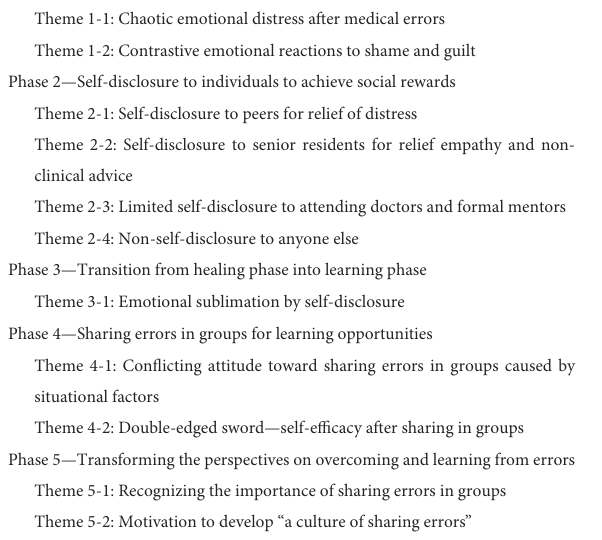
TABLE 3 Summary of the result emerged from the analysis. Phase 1—Emotional distress and reactions before self-disclosure Theme 1-1: Chaotic emotional distress after medical